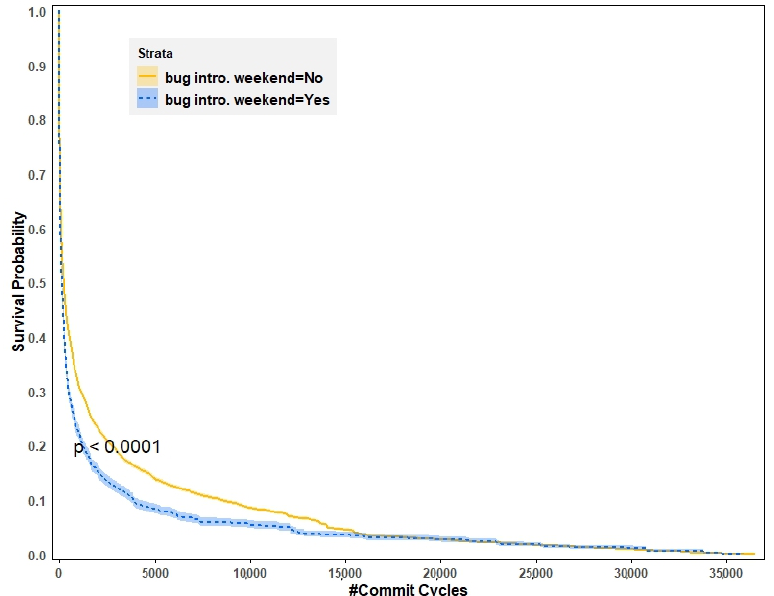
Figure 4. Kaplan–Meier estimations of the survival function for the scenario when bugs are intro- duced during the weekend and vice versa.